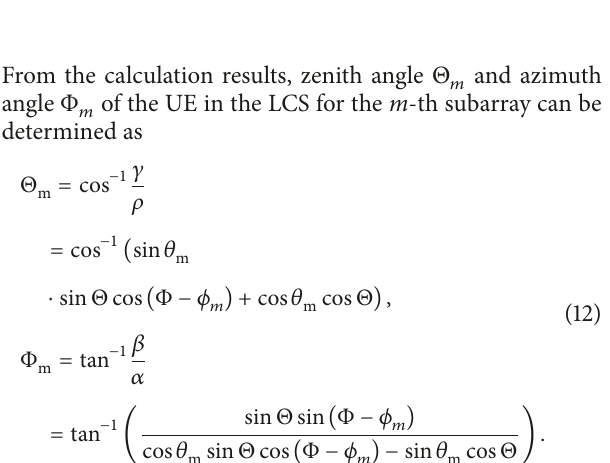
Figure 4: Angle parameters for the GCS and the